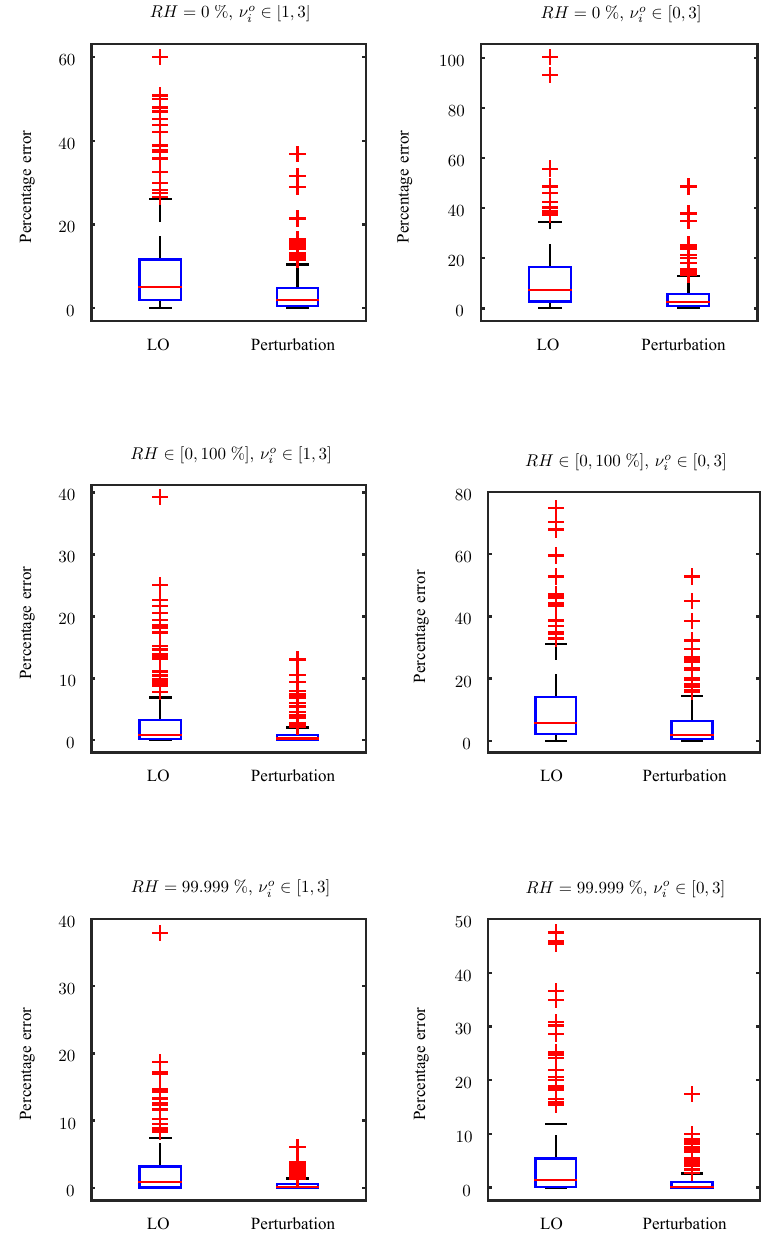
Figure 8. Comparison of the percentage errors in organic mass fraction from the two approximations in relation to those calculated using the non-linear solver for the data points in Fig. 7. The leading-order (LO) and perturbation solutions are shown by the left and right box and whisker plots in each figure,